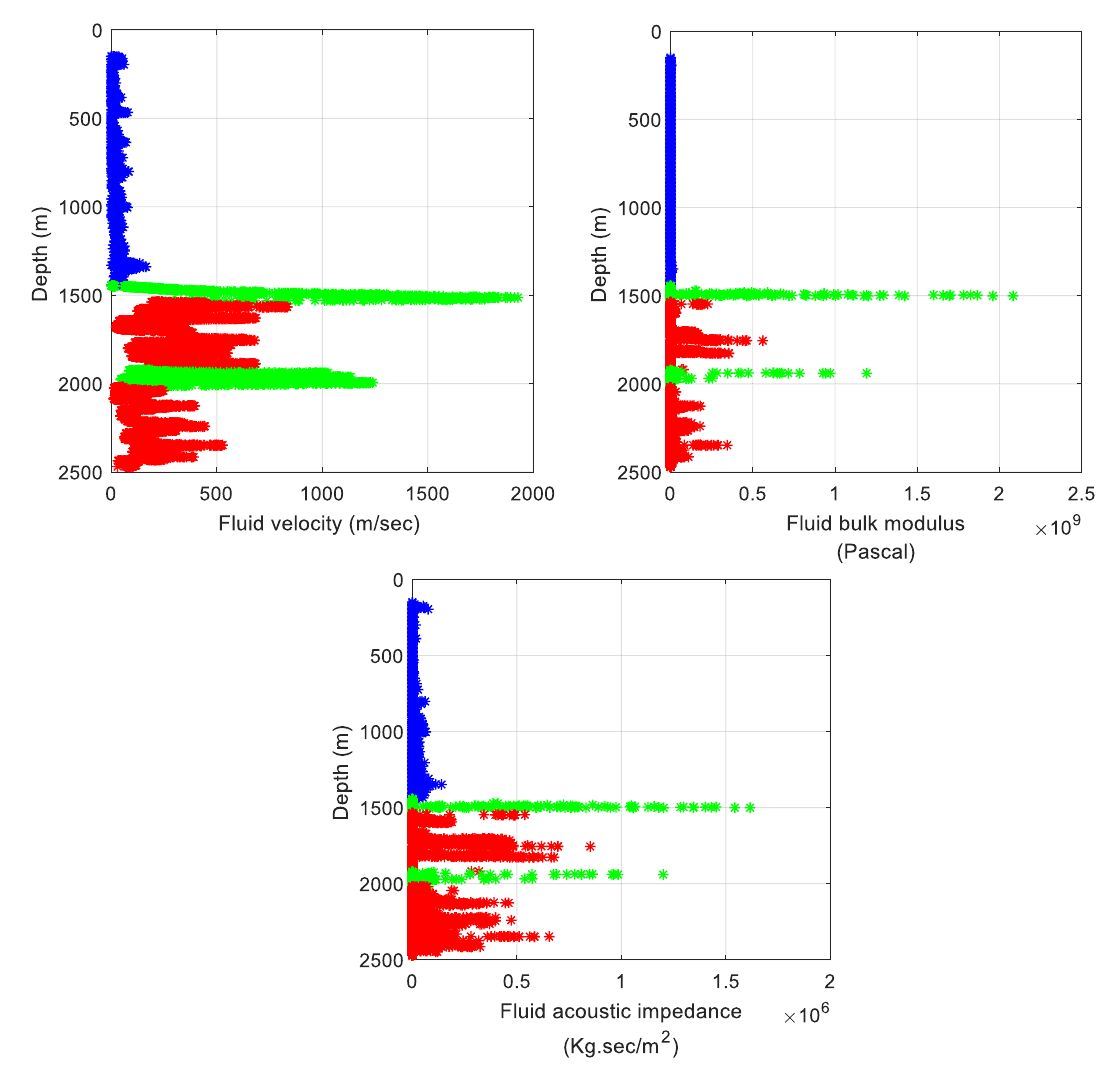
Fig. 11 Fluid velocity, bulk modulus, and acoustic impedance